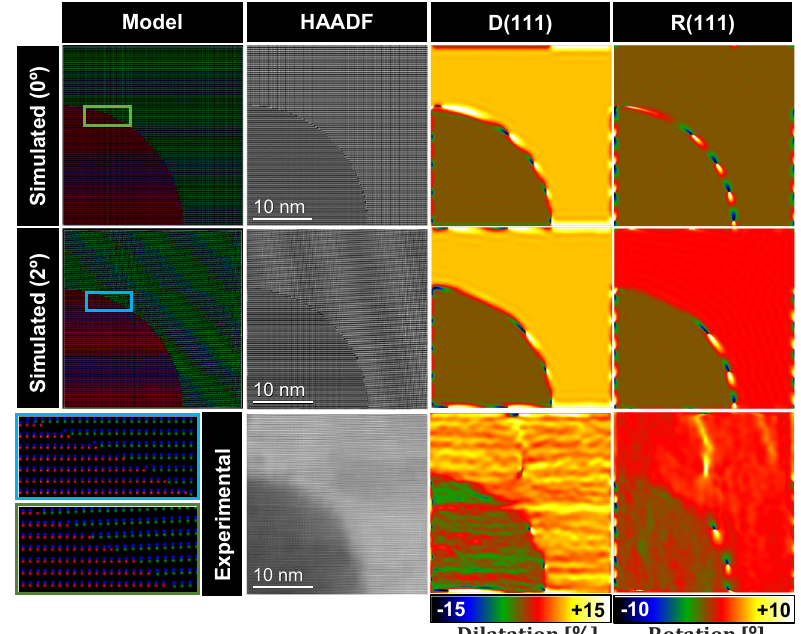
Fig. 3 Study of the shell relaxation mechanism. (Two-upper-rows) (Model column) Atomic modeling of a NW top-right section reproducing the experimental morphology (ZnTe presenting a 2° rotation around the1 – 21 axis), along with a hypothetical con fi guration with ZnTe planes completely parallel to ZnSe ones (0°). (HAADF Column) HAADF-STEM micrograph simulations of both con fi gurations along with GPA dilatation (D) and rotational (R) maps for the (111) structure planes of the simulated models in comparison with the equivalent experimental analysis in the same NW section (bottom-row). The left color bar represents the geometrical phase analysis calculated (111) planes percentage dilatation (%), while the right color bar represents the geometrical phase analysis calculated (111) planes rotation in degrees